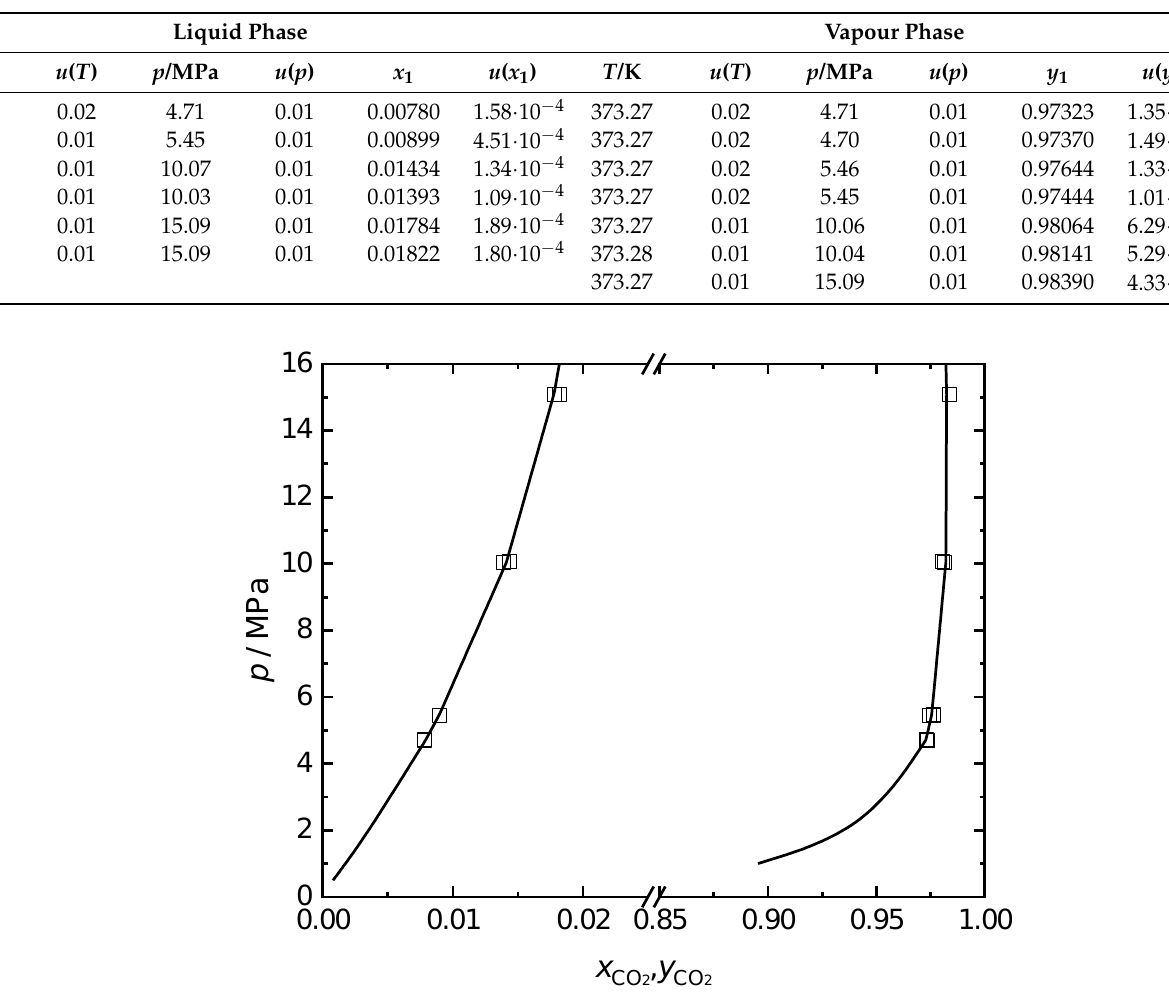
Figure 3. Vapour–liquid equilibrium for CO 2 (1) + H 2 O(2) systems at 373 K. Symbols represent the experimental data measured in this work, and the black line is the model reported by Spycher et al. [20].